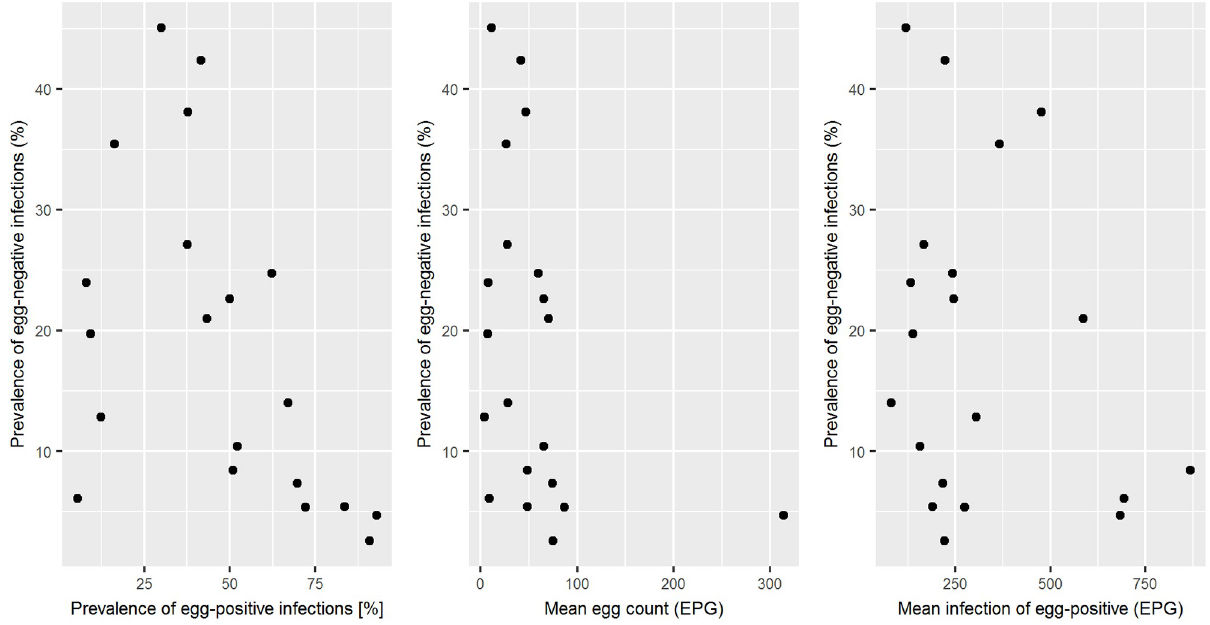
Fig 3. Relation between egg-negative prevalence, egg-positive prevalence, mean egg count in the population, and mean infection intensity of an infected individual.